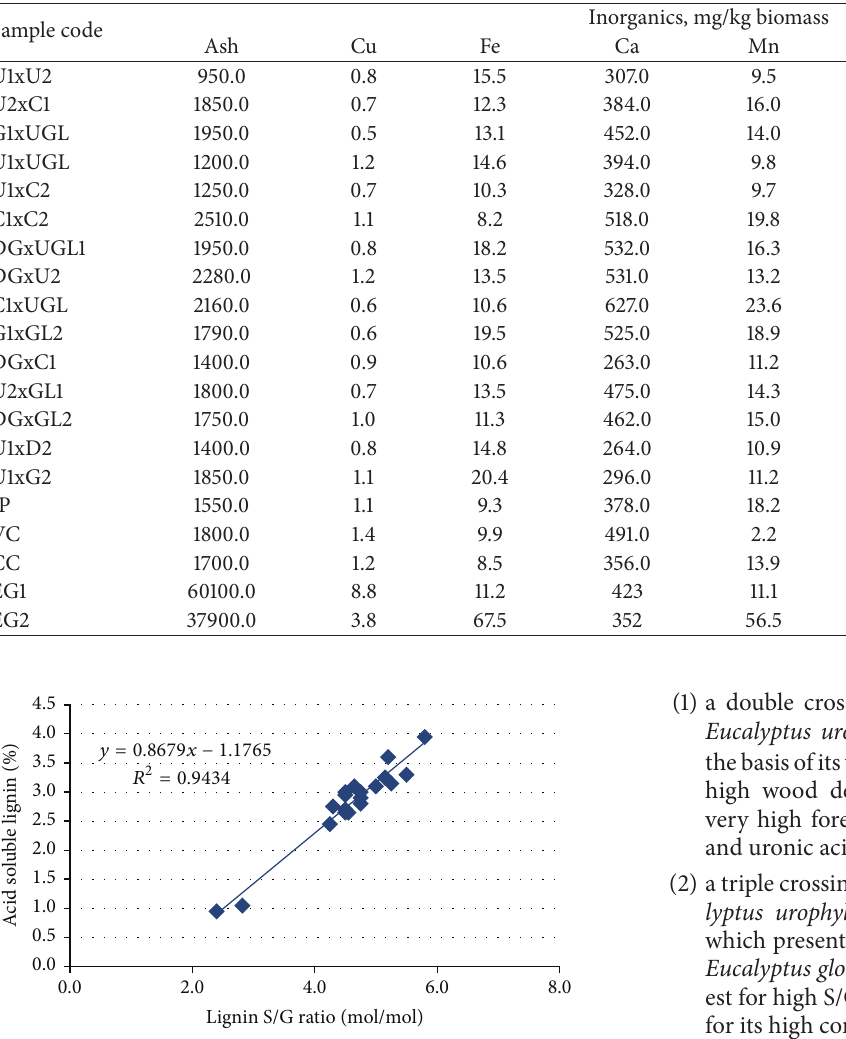
Figure 1: Correlation between biomass acid soluble lignin and lignin S/G